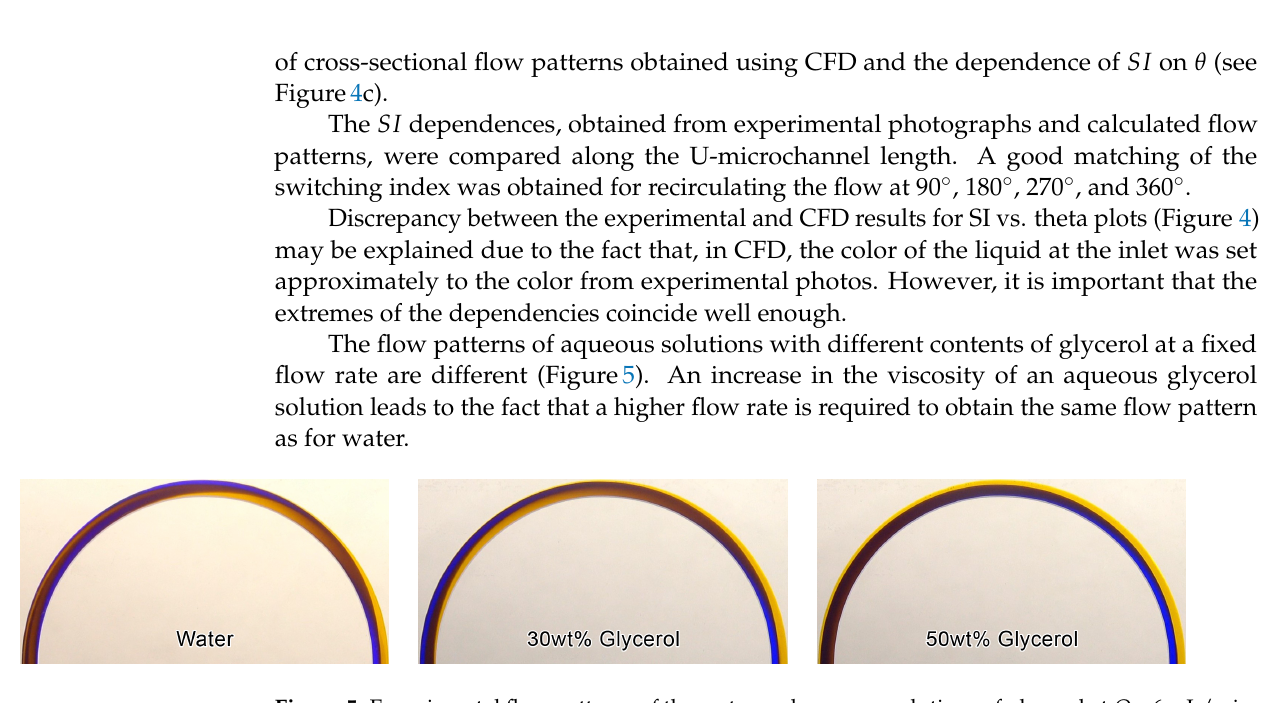
Figure 5. Experimental flow patterns of the water and aqueous solutions of glycerol at Q